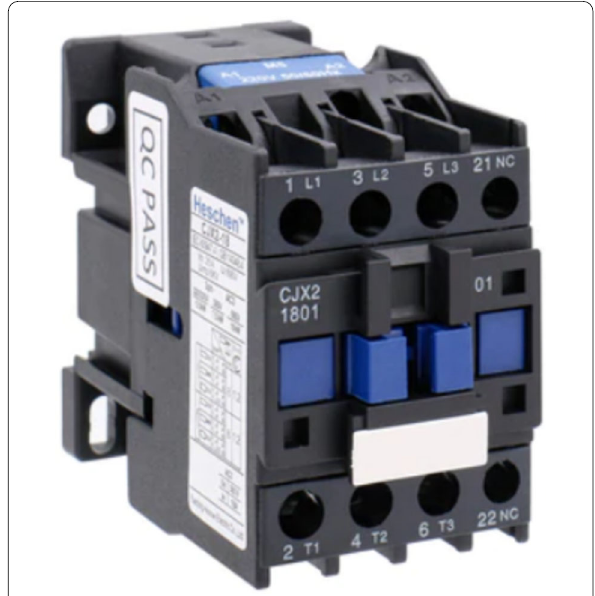
Figure 4 The diagram of the AC contactor